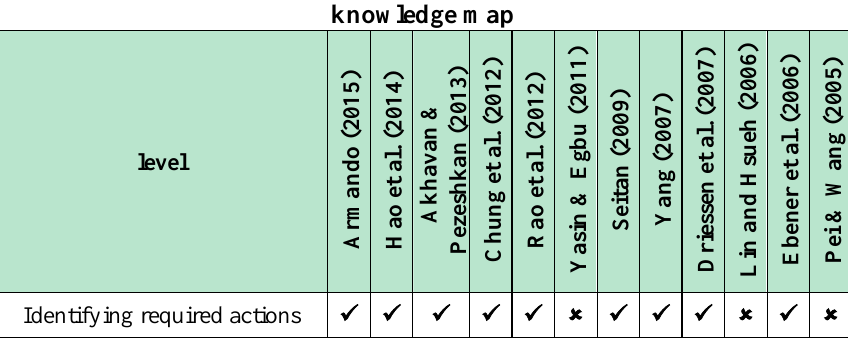
Table 5: An example of extracting and applying the steps of the knowledge